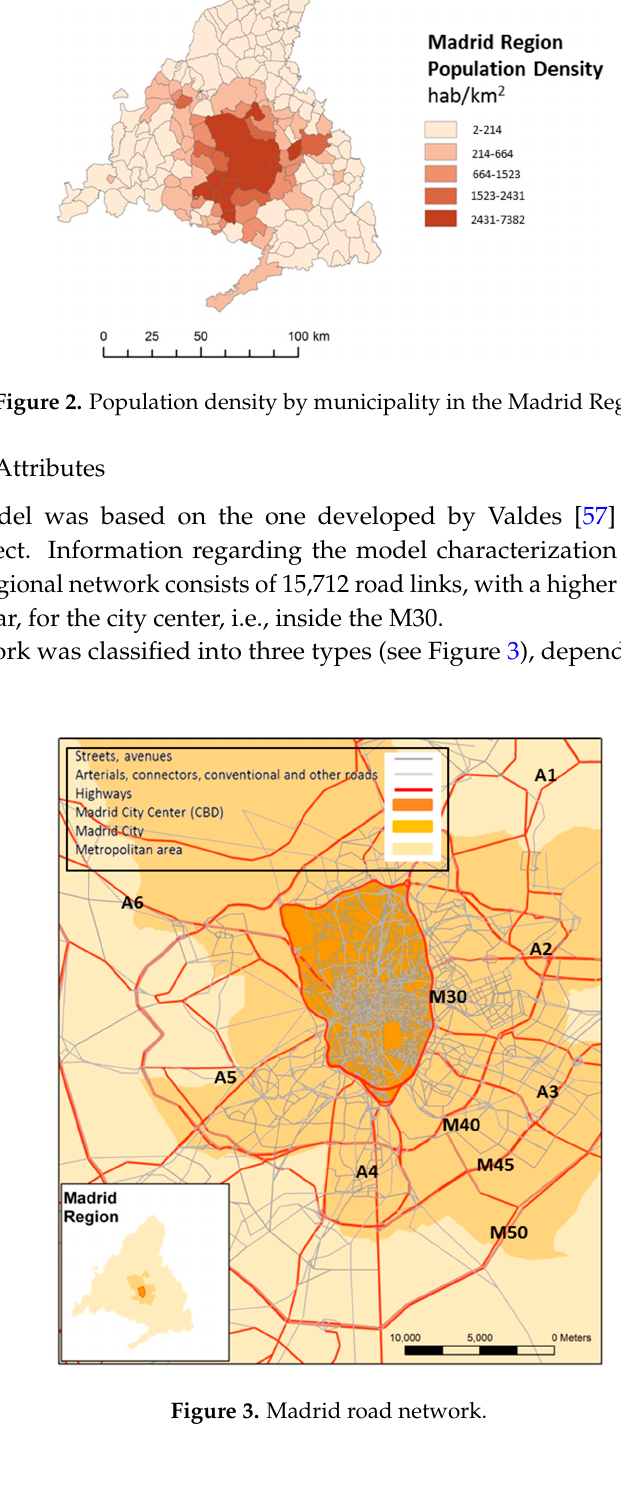
Figure 3. Madrid road network.